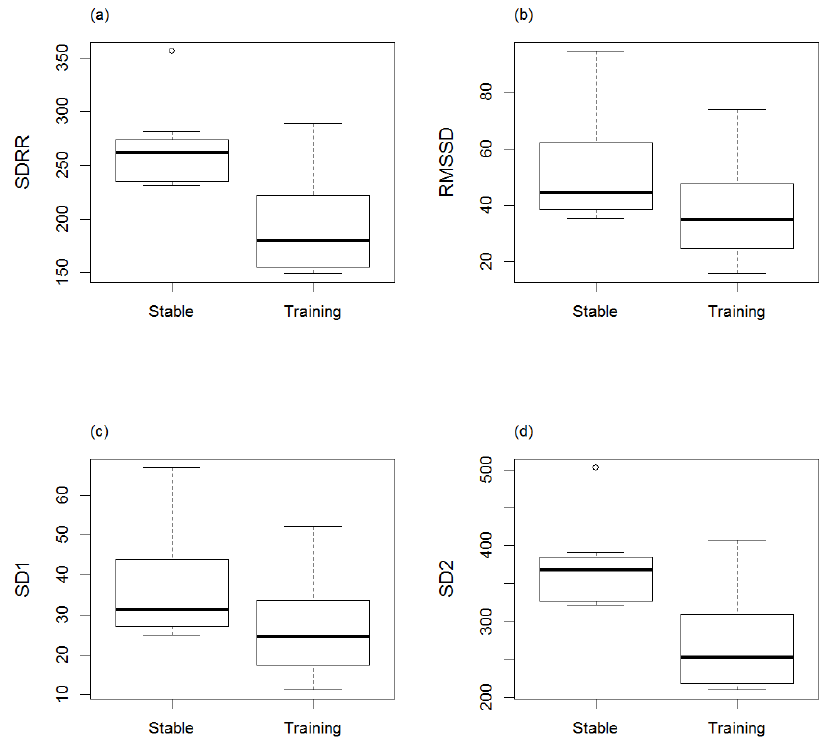
Figure 2. Standard deviation of the RR interval (SDRR) ( a ), root mean square of successive RR differences (RMSSD) ( b ), and the geometric means standard deviation 1 (SD1) ( c ) and 2 (SD2) ( d ) of horses before training (Stable) and during Monty Roberts’ public demonstrations (Training). SDRR, RMSSD and geometric means SD1 and SD2 were significantly lower in training (RR: SDRR: p = 0.001; RMSSD: p = 0.0489; SD1: p = 0.0489; SD2: p = 0.001). Analysed using generalized linear mixed models (GLMM) and the Wilcoxon signed-rank test.